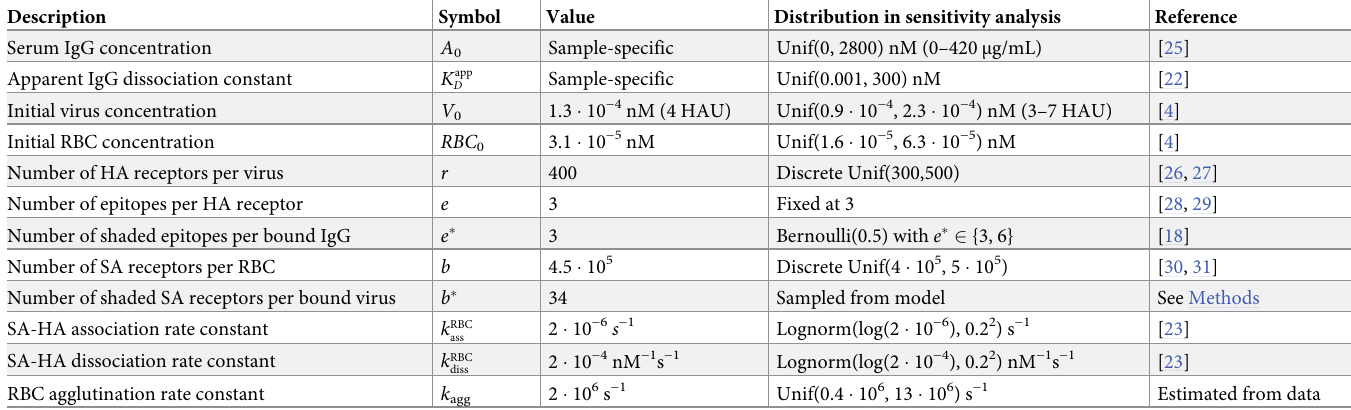
Table 1. Model parameters and variables. The assumed ranges of uncertainty and biological variability in model parameters and variables are defined by the distributions used in the sensitivity analysis. Abbreviations are: IgG, Immunoglobulin G; RBC, red blood cell; HA, hemagglutinin; HAU, HA unit; SA, sialic